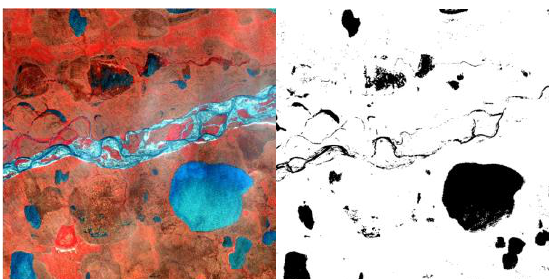
Figure 2. (a) The sample satellite images with water bodies.